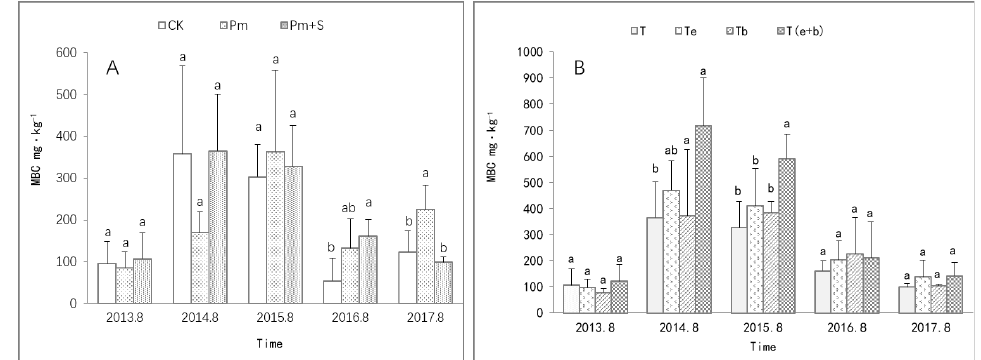
Figure 7. Dynamic change of soil microbial biomass carbon content. Bars represent standard errors. Lower case letters above each panel show statistical signif-icance at p < 0.05. CK pig manure, S slurry, e earthworms, b bacteria, T Pm + S, Te T + earthworms, Tb T + bacteria, T(e + b) T + earthworms + bacteria ( A ) Pig manure, biogas slurry agricultural use ( B ) Biological control.